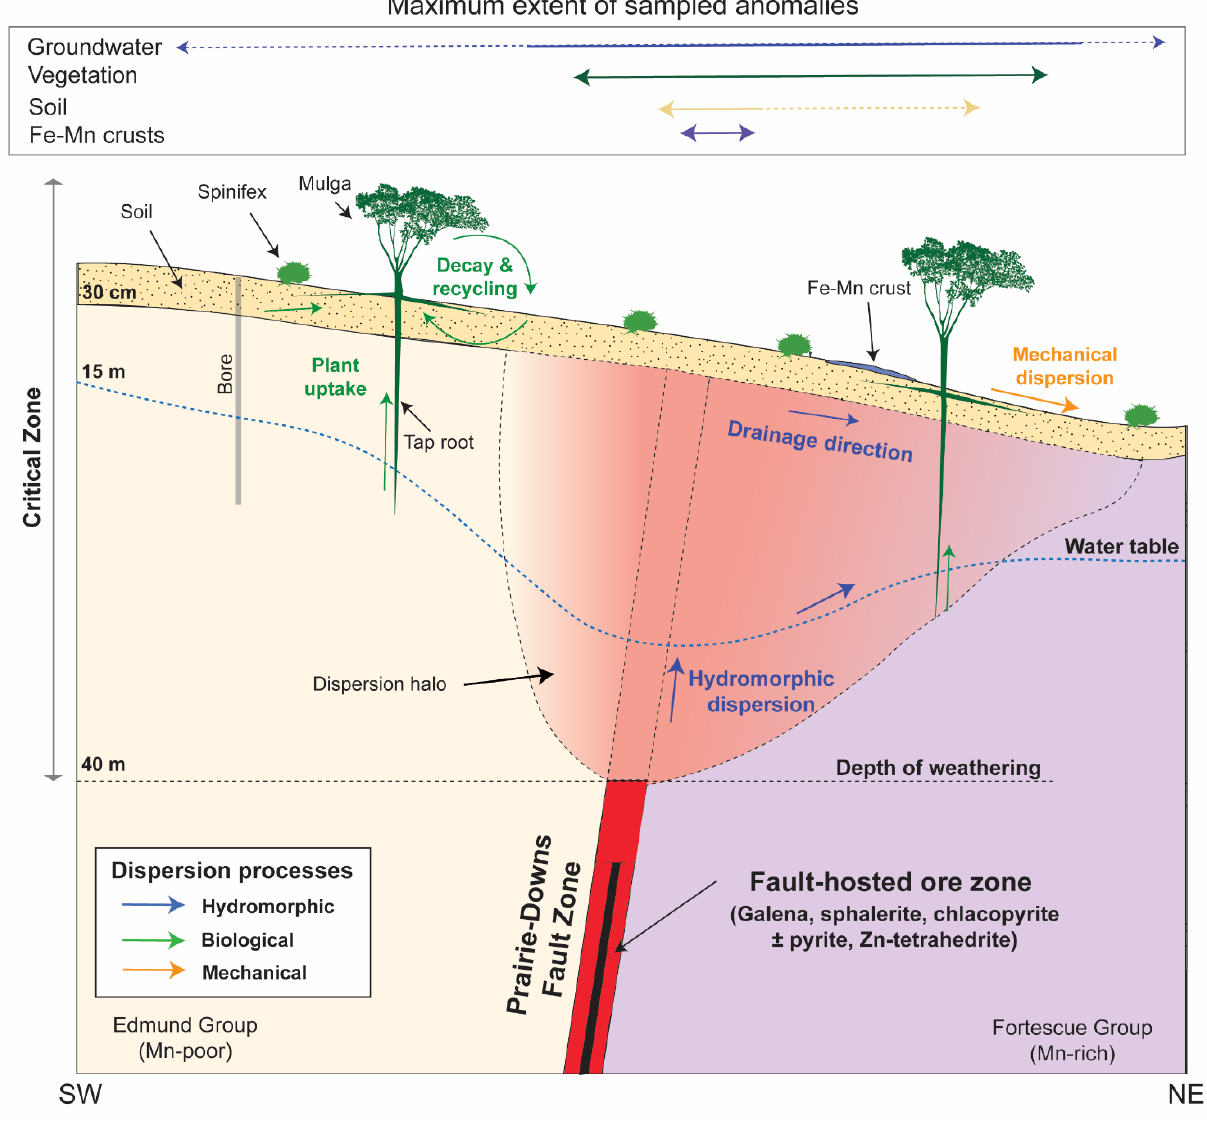
Figure 10. Summary sketch of the main metal dispersion processes related to sample media collected over the Prairie-Wolf study area. Sketch is not to scale.